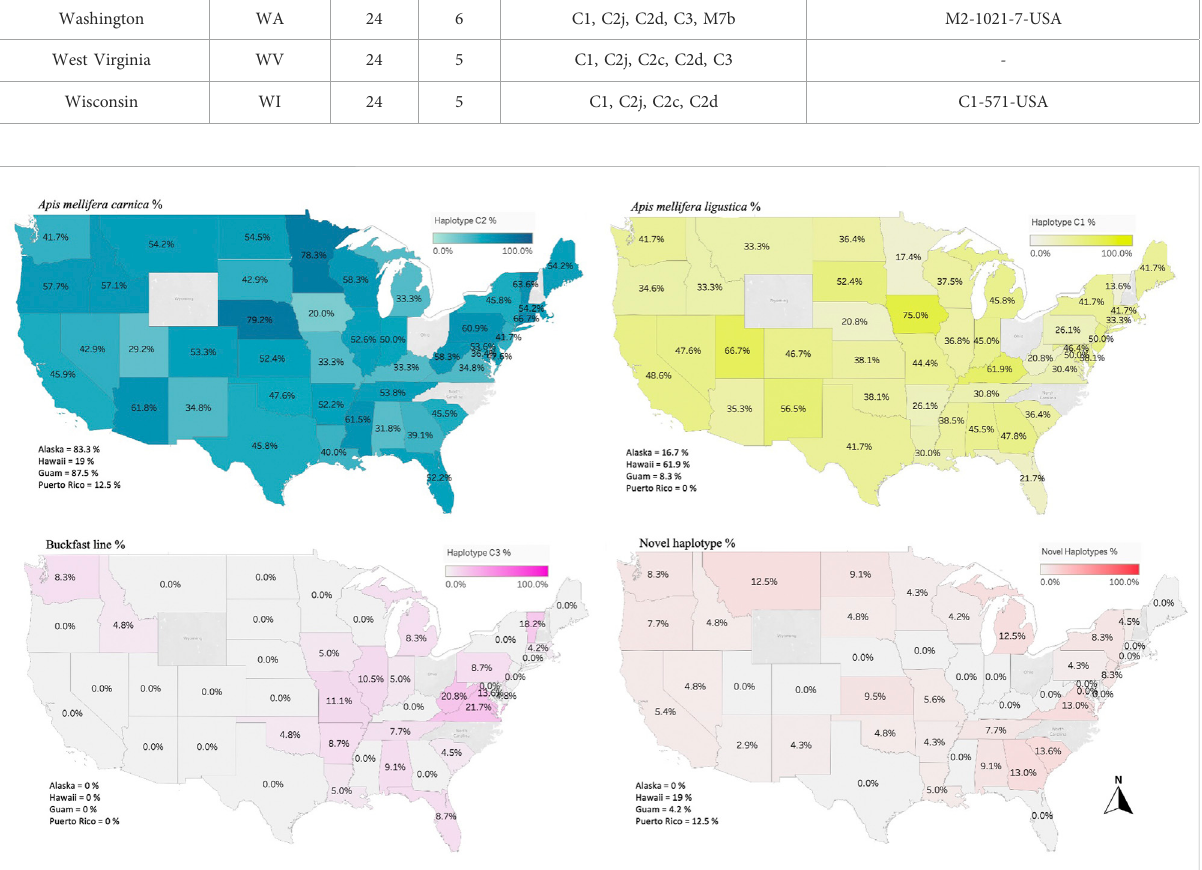
FIGURE 4 Major three haplotypes found in the honey bee populations of the USA. Haplotype C1 characterizes the honey bee subspecies A. m. ligustica (Italianhoneybee),C2haplotypefor A.m.carnica (Carniolanhoneybee)andC3representstheBuckfastline.Novelhaplotypesfoundinthisstudyare also provided in percentage of the total analyzed samples per